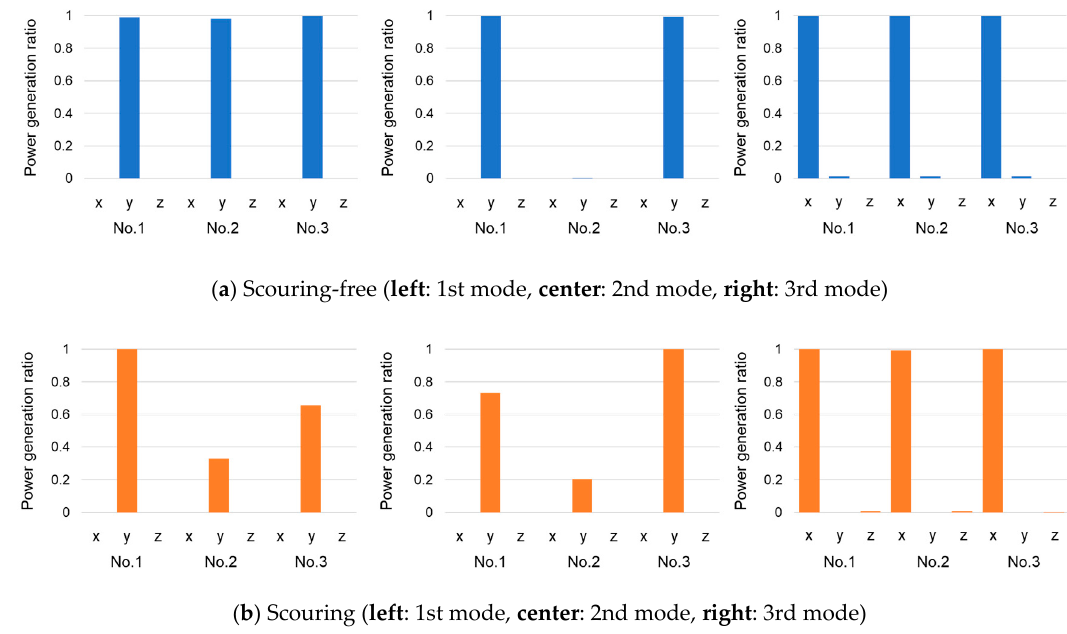
Figure 13. Output power generated by MEH (Pier model).